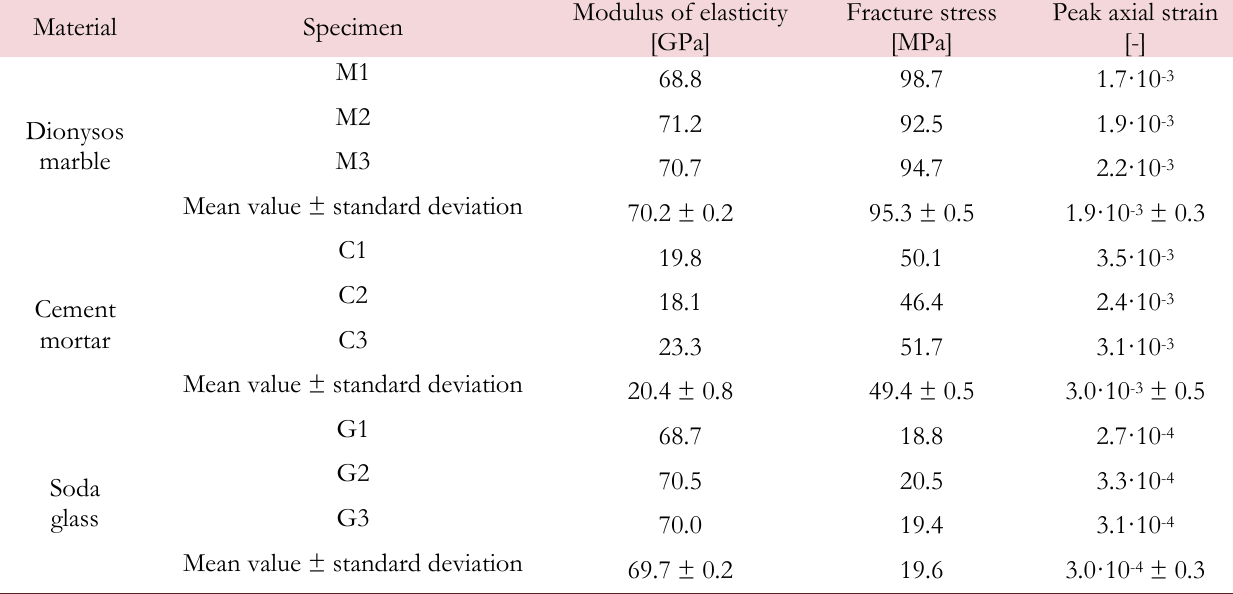
Table 2: The mechanical characteristics of all